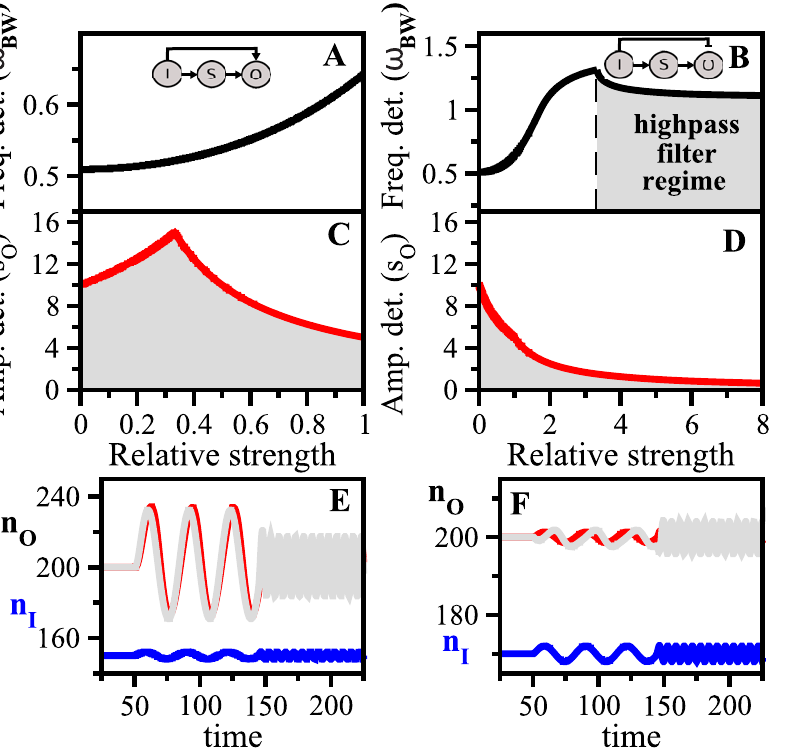
Figure 3. Amplitude/frequency detection in feed-forward loops. Frequency detection (bandwidth v BW , panels A, B) and amplitude detection (output susceptibility s O , panels C, D) versus relative strength RS for coherent (left) and incoherent (right) feed-forward loop modules. Susceptibilities and time scales as in Figs. 2A–D. (E) Blue line: Input signal at two different frequencies, v =0.2 and v =1 t { 1 . Grey line: Response of a coherent FFL module with RS=0.33 and s O =12 (larger than the maximum value allowed for a linear cascade, Figure 3C). Red line: Response of a positive feedback circuit with the same susceptibility (FS=0.33). (F) Blue line: Input signal at v =0.2 and v =1 t { 1 as in Figure 3E. Grey line: Response of an incoherent FFL module with s O =0.6 (RS=6). Red line: Response of a negative feedback module with the same susceptibility (FS=6).